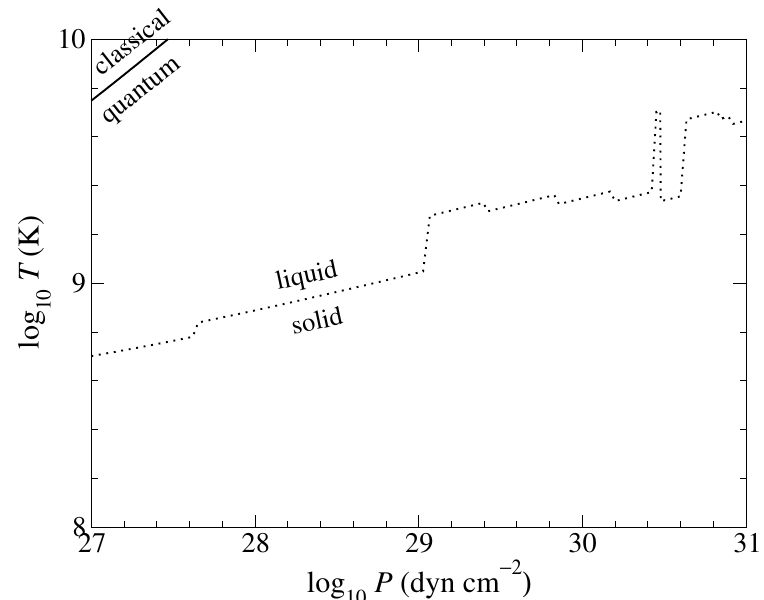
Figure 1. Characteristic temperatures in the outer crust of a magnetar with a magnetic field strength B (cid:63) = 2000 ( B ≈ 8.83 × 10 16 G) as a function of the pressure P (in dyn cm − 2 ): electron Fermi temperature T F e (solid line) separating the quantum (degenerate gas) and classical regimes and melting temperature T m (dotted line) separating the liquid and solid phases (assuming Γ m = 175). The Coulomb plasma temperature T (cid:96) separating the weakly and strongly coupled plasma regimes is much higher and is not shown. The magnetic field is strongly quantizing for all pressures and temperatures shown (in the present case, T B = 1.19 × 10 13 K): electrons are confined to the lowest Landau–Rabi level. Composition taken from